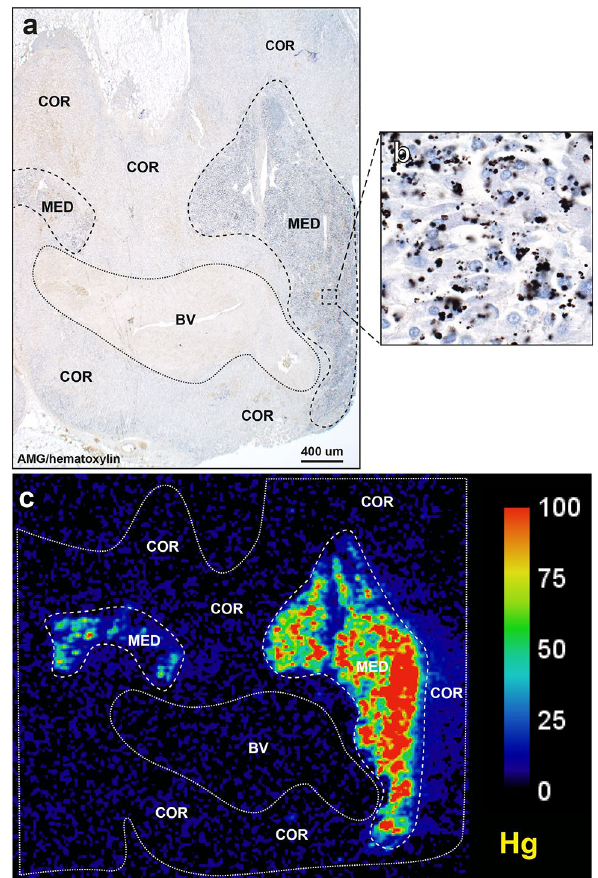
Figure 5. Co-localisation of mercury by AMG and LA-ICP-MS. ( a ) Black AMG staining is present in two regions of the adrenal medulla (MED), but not in the adjacent adrenal cortex (COR), or in a large blood vessel (BV). AMG and hematoxylin. ( b ) An enlargement of the area within the box in ( a ) shows numerous chromaffin cells containing black AMG grains. ( c ) LA-ICP-MS of an adjacent section shows mercury in the two adrenal medulla regions, but not in the cortex or blood vessel. All images from a 98 year-old male. Scale = counts per second (proportional to